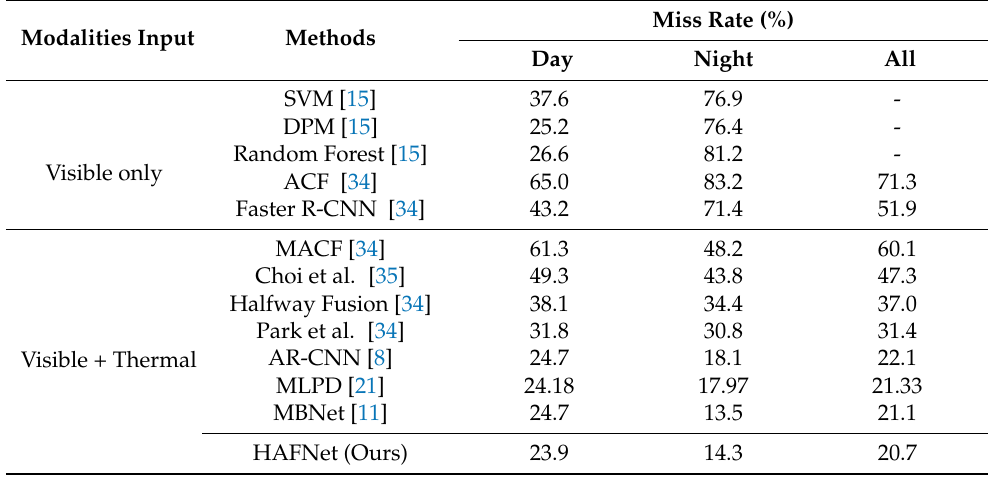
Table 3. Evaluation results comparison on the CVC-14 dataset. We use the reimplementation of ACF, Faster R-CNN, MACF, and Halfway Fusion in literature